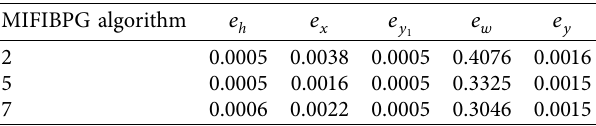
Table 9: Estimation errors for the FSOEAHW model using MIFIBPG algorithm with L � 2, 5, and 7. MIFIBPG algorithm